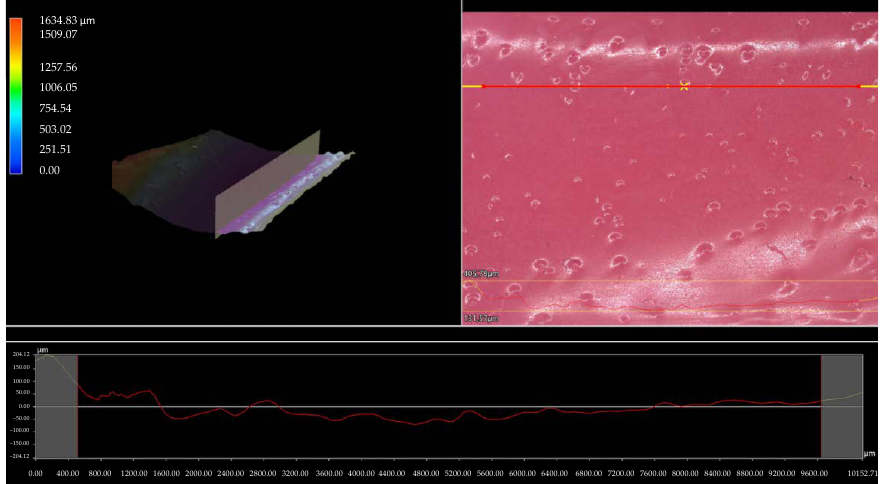
Figure 6. 3D view and the roughness profile (along the red line) of sample 700/7.5.